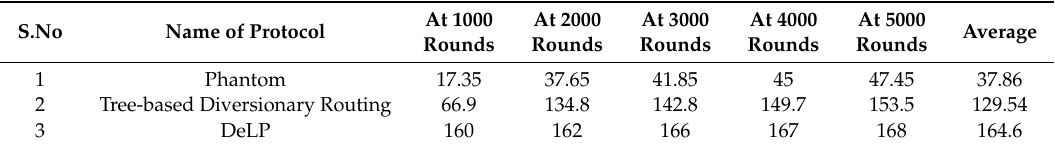
Table 4. Comparison of safety period after equal